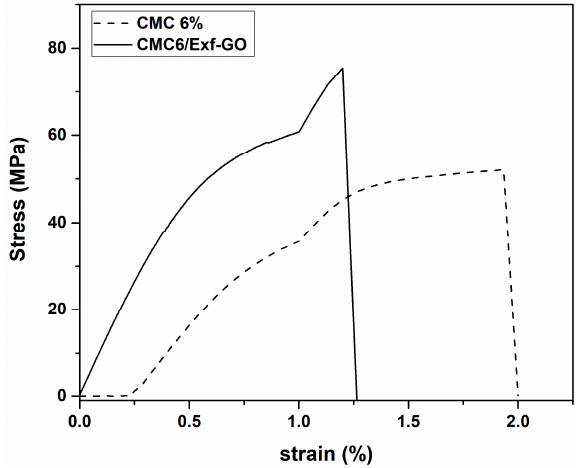
Figure 6. Stress-Strain curves of CMC6/ Exf -GO nanocomposites and CMC 6% film.